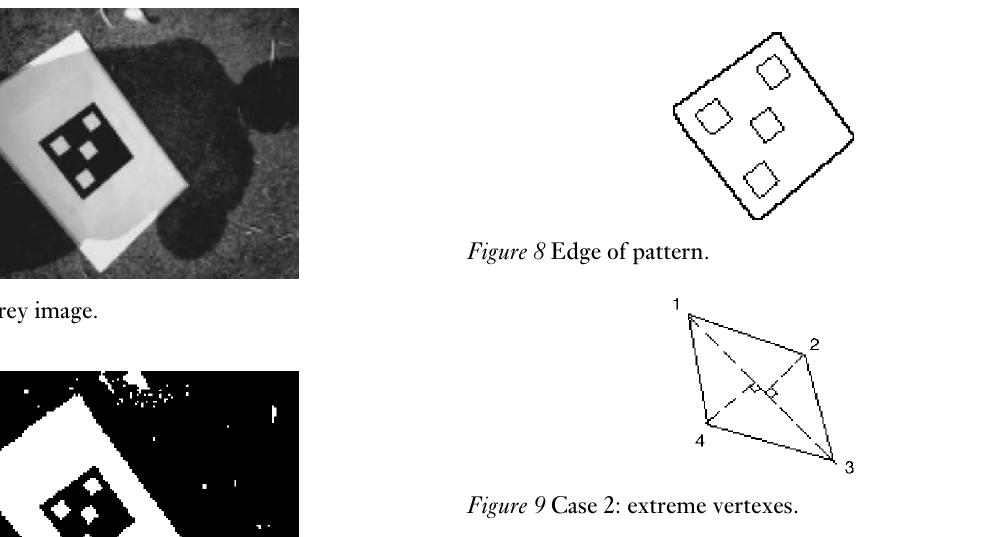
Figure 7 After filter by width/length ratio.